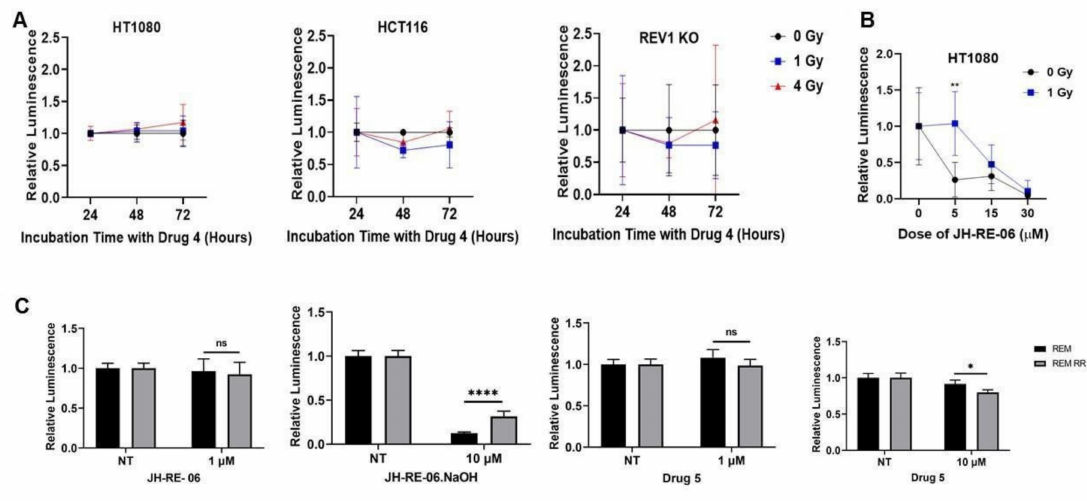
Figure 2. REV1 inhibition does not sensitize cancer cells to ionizing radiation. ( A ) Graphs show relative luminescence with increasing incubation times (24, 48, and 72 h) with drug 4 (7922759) and increasing doses of IR (0, 1, and 4 Gy) in the HT1080 and HCT116 cell lines. Also shown are relative luminescence intensities in MEF REV1 KO cells after exposure to 1 and 4 Gy ionizing radiation and incubation for 24, 48, and 72 h. ( B ) Relative luminescence in HT1080 treated with 0, 5, 15, and 30 µ M of JH-RE-06 with 1 Gy of IR exposure. ( C ) Relative luminescence in REM and REM RR cells in response to treatment with JH-RE-06, JH-RE-06.NaOH, and drug 5 (4053831). p -Values are * p < 0.05, ** p < 0.01, and **** p < 0.0001. Error bars represent standard deviations. p -Values were calculated by 2-way ANOVA. N = 6 for all